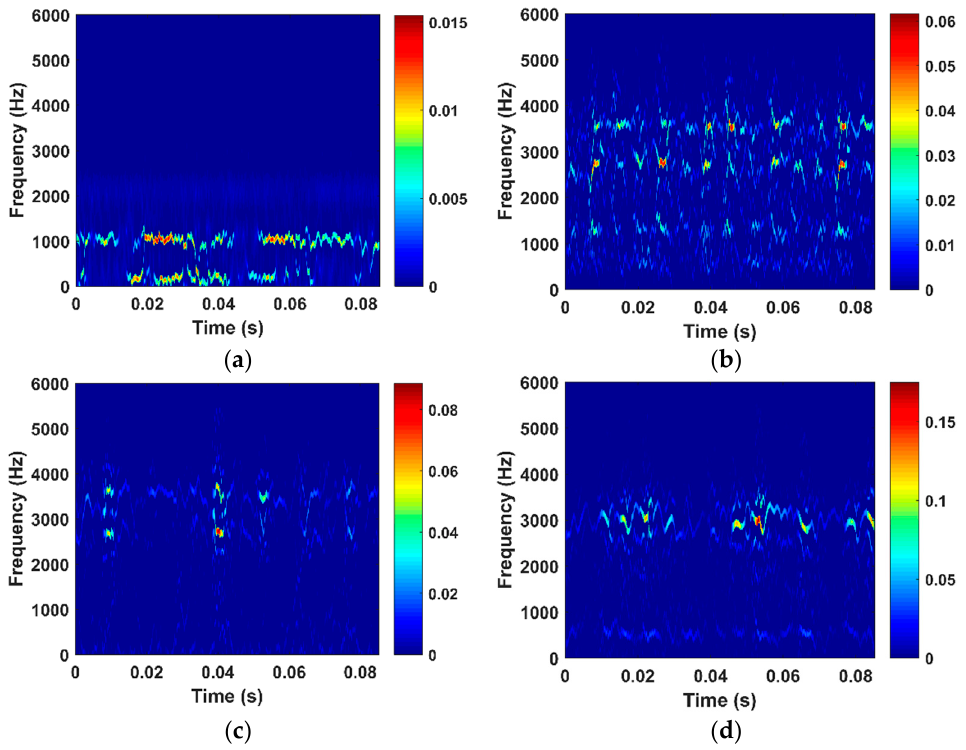
Figure 11. TFIs obtained using the STFA-PD from bearing vibration signals of different severity degrees: ( a ) 0.000 in, ( b ) 0.007 in, ( c ) 0.014 in, and ( d ) 0.021 in. ( a ) 0.000 in, ( b ) 0.007 in, ( c ) 0.014 in, and ( d ) 0.021